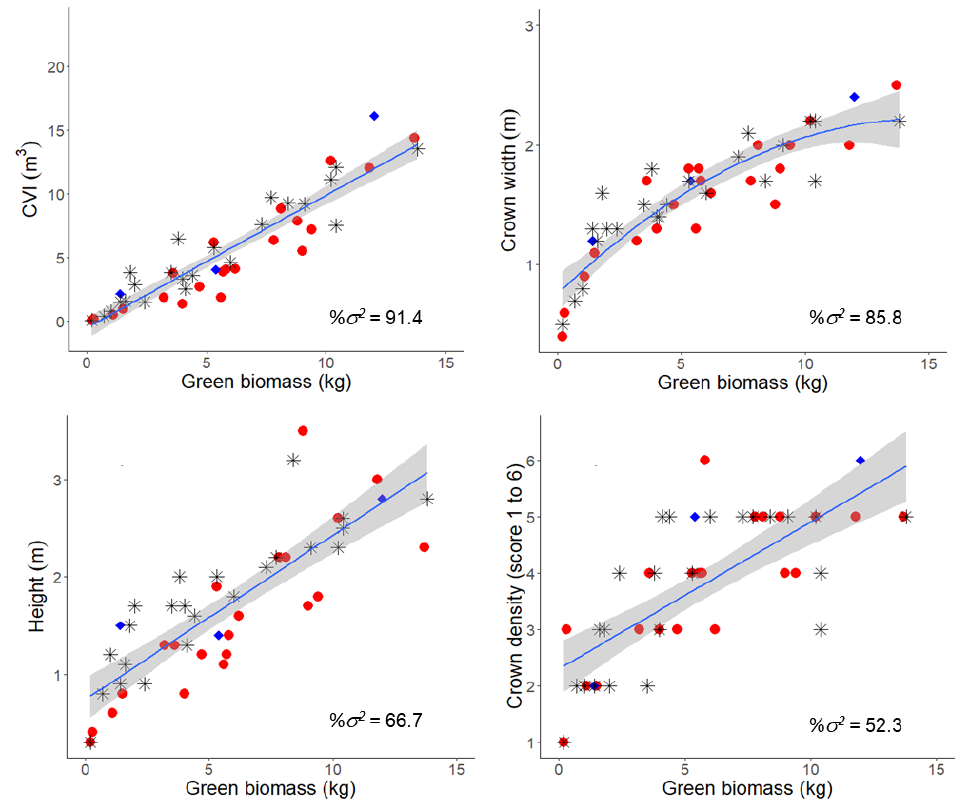
Figure 2. Fitted relationships between green biomass (BM) and explanatory variables including crown volume index (CVI), height (HT), crown width (CW) and crown density score (CW). Regions of provenance are represented by red circles (SA); asterisks (NSW) and blue diamonds (Victoria). The 95% confidence intervals for the fitted blue lines are indicated by the surrounding grey regions. The relationship between BM and the subjectively scored CD trait was also significant ( p < 0.001), explaining 52.3% of the variance.